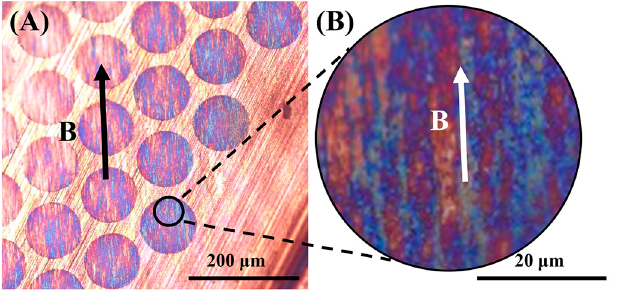
Figure 16. ( A ) Optical microscope images of aligned GO@Fe 3 O 4 nanoparticles on the substrate; ( B ) the enlarged view in the black circle of ( A ). (The B shows the direction of the magnetic field).